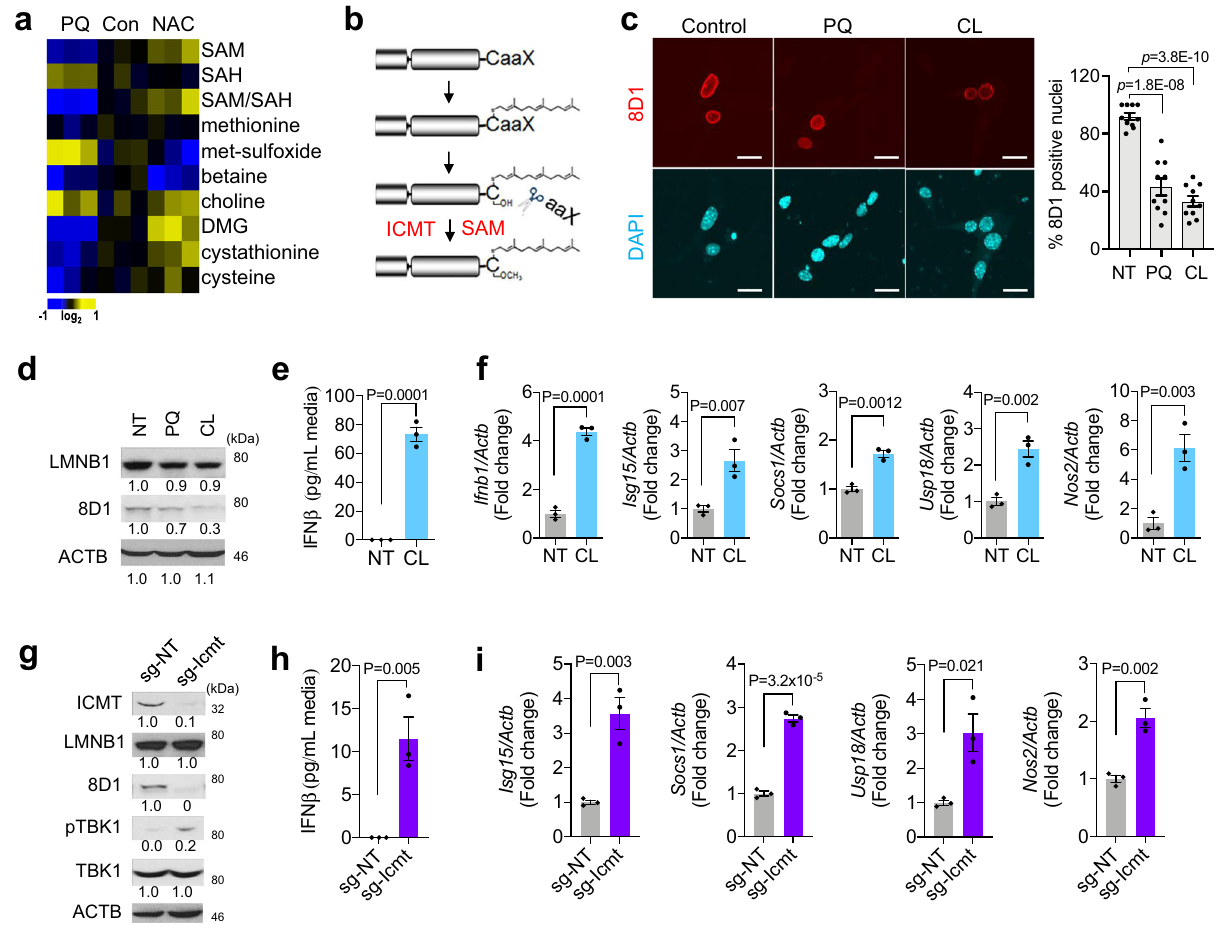
Fig. 5 Stress-depleted intracellular SAM underlies nuclear leakage through lamin B1 maturation failure. a Heatmap for metabolites extracted from NSPCs after 2 days of respective treatment. Data are presented as three independent experiments. SAM: S-adenosyl-methionine, SAH: S-adenosyl- homocysteine, DMG: dimethylglycine. b Diagram for lamin processing. c Left, IF images for mature lamin B1 (8D1, red) following 48 h of PQ or CL treatment. CL: 25 mM of cycloleucine (1-aminocyclopentanecarboxylic acid). Right, quantitation for 8D1-positive nuclei. Scale bar = 10 µ m. Mean ± s.e.m. of ten images. d WB results for total laminB1 (LMNB1) and mature laminB1 (8D1). IFN β secretion in the media ( e ) and qRT-PCR analysis for ISGs ( f ) following 48 h of CL treatment. Mean± s.e.m. of three independent experiments. g WB for defect of lamin processing and IFN-I activation in Icmt-targeted guide RNA transduced NSPCs (sg-Icmt). IFN β secretion in the media ( h ) and qRT-PCR analysis for ISGs ( i ) following 48 h growth. Mean ± s.e.m. of three independent experiments. Statistical signi fi cance was determined by one-way ANOVA for ( c ) and by two-sided unpaired t-test for ( e , f , h , and i ). Experiments for c , d , and g were repeated three times independently with similar results and representative images/blots are